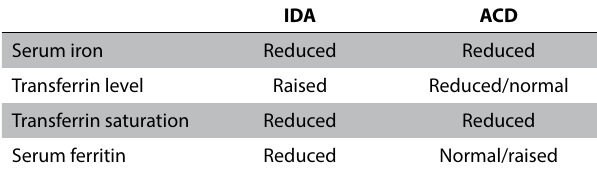
Table 2. Results of biochemical investigations in IDA vs ACD